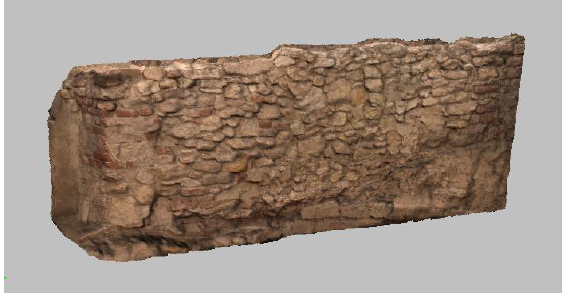
Figure 7. Digital Object Model generated from a